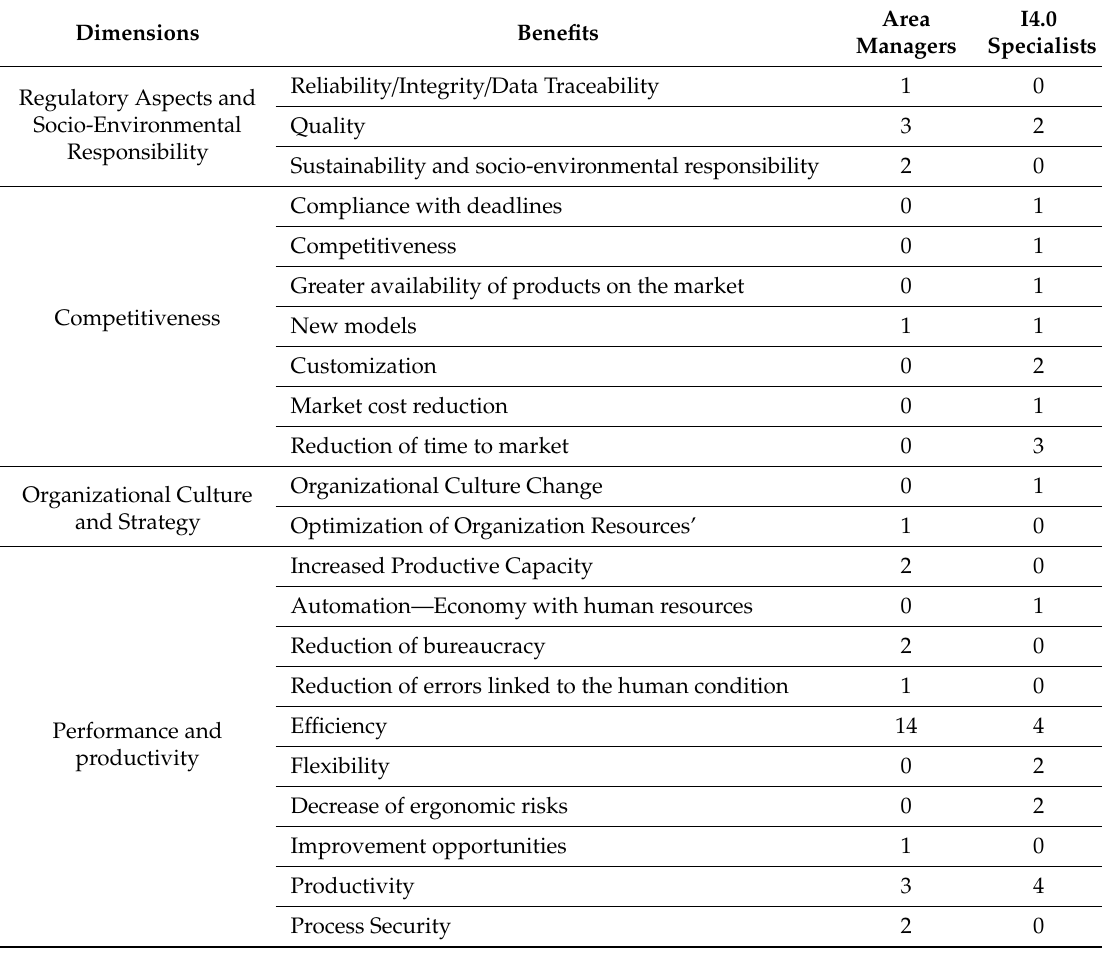
Table 3. Benefits scored by category of respondents considering the established dimensions—number of